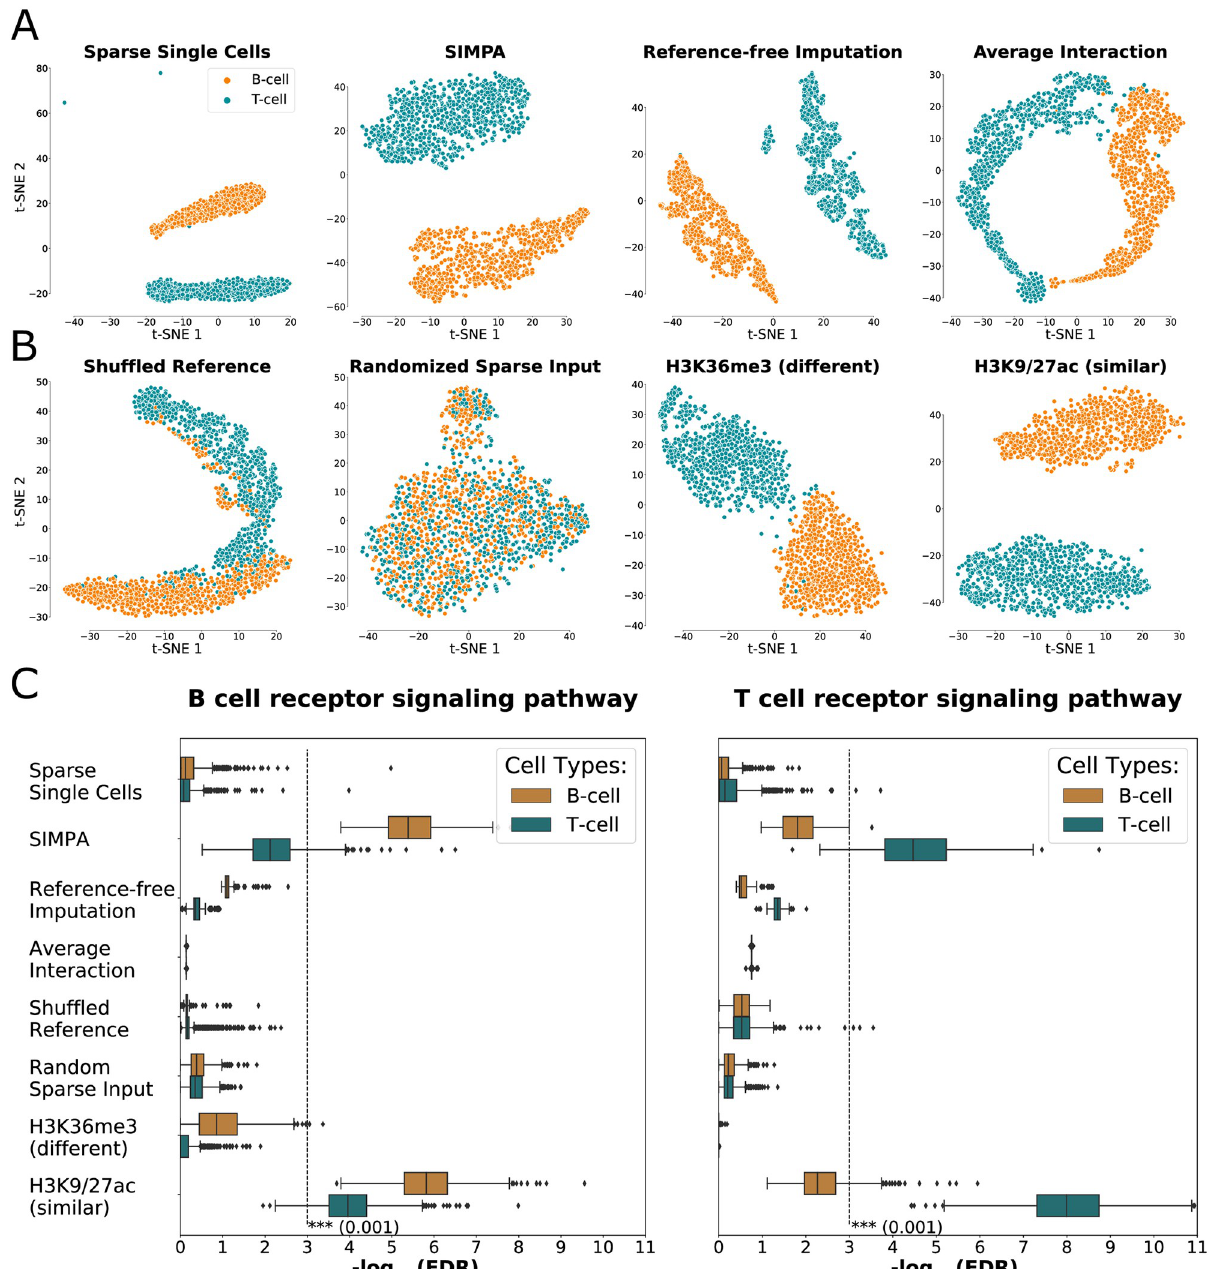
Fig 5. Cell-type specificity validation. A + B Separation of single cells according to cell type . A . Dimensionality reduction analysis applied on the human H3K4me3 data derived from (i) the sparse single-cell data and three different imputation methods, (ii) SIMPA, (iii) reference-free imputation, and (iv) average interaction based on expected frequencies in the reference set. Results from SIMPA and from the reference-free method achieve the best clustering by separating the single cells (points) by cell types (colors). B . Effects of input modification on SIMPA, (i) using a shuffled reference set or (ii) randomized sparse input data, or using other histone marks as reference instead of H3K4me3, either (iii) the functionally different histone mark H3K36me3, or (iv) the functionally similar histone marks H3K9ac and H3K27ac. Only SIMPA used with relevant protein targets was able to correctly cluster all single cells (no outliers). C. Pathway enrichment analysis . Boxplots show the significance of pathway enrichment analyses of genes annotated by single-cell regions as log-transformed false discovery rate (FDR; x-axis). Each dot represents the FDR of one single cell from the results of the different analysis experiments shown in A+B (y-axis). The dashed lines represent the log-transformed significance threshold of an FDR equal to 0.001. Only SIMPA achieves significant results by imputing preferably genomic regions associated with relevant pathway-related genes.